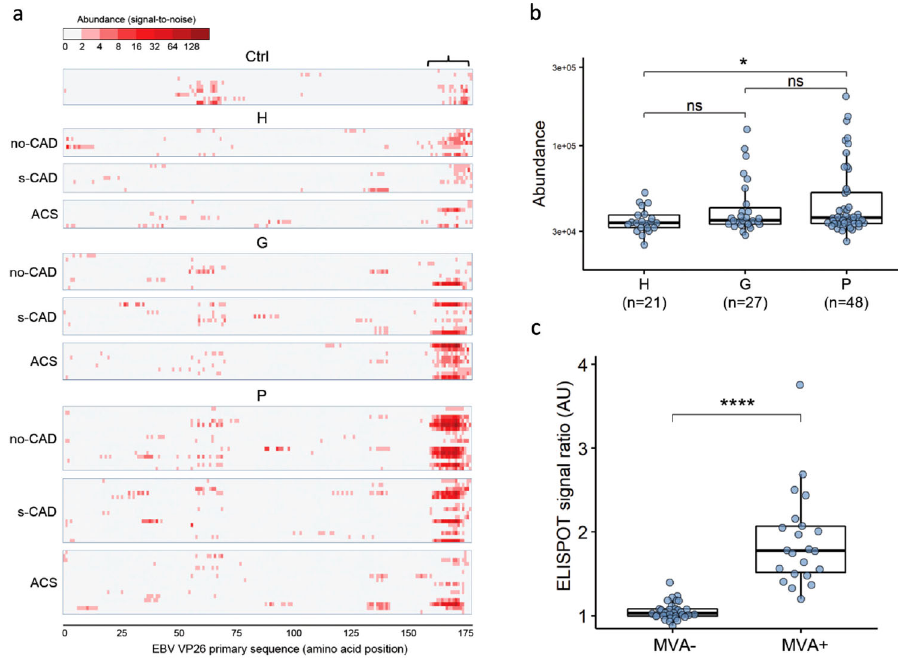
Fig. 4 Immunoreactivity to epitope on VP26 EBV and alike mimicking features strati fi es patients with periodontitis. a Individual immunoreactivity pro fi les ( n = 96) of the study cohort against EBV protein VP26, shown for different clinical groups: periodontally healthy (H), gingivitis (G), or periodontitis (P). All peptides from individual immunopro fi les were aligned (with ≥ 6 matching amino acid positions) to primary sequence of EBV VP26 protein along with random reference. Peptide epitope abundance (as signal-to-noise ratio, red color-scale ) is visualized per subject ( in rows , separated into periodontal diagnosis groups) and per amino acid position (on x-axis ). Ctrl – samples with negative EBV-viral capsid antigen serology ( n = 9). b Highly antigenic P..T.PR epitope is differentially targeted across periodontal groups shown as box plots of abundance of peptides containing the epitope (Mann – Whitney U , two- sided, p values not corrected for multiple comparisons, * p < 0.05, ns p > 0.05, n = 96 independent patients), Supplementary File S6. a , b Abbreviations and group sizes: H periodontally healthy ( n = 21 patients (3 × 7)), G gingivitis (n = 27 (3 × 9)), P periodontitis ( n = 48 (3 × 16)), no-CAD no CAD diagnosis ( n = 32), s-CAD stable CAD ( n = 32), ACS acute coronary syndrome ( n = 32). c Anti-P.DT.PR epitope-like immune response identi fi ed by MVA was in high correlation with data from independent dot ELISA validations. Phage particles displaying peptides with P.DT.PR or mutant P.DA.PR sequences were used for dot ELISA. Of the 52 randomly tested samples, those with a positive signal to anti-P.DT.PR response detected by MVA (>1200 abundance of P.DT.PR containing peptides, MVA + ) showed signi fi cantly higher signals in dot ELISA ( y-axis, signal-to-background arbitrary unit (AU) ) compared to